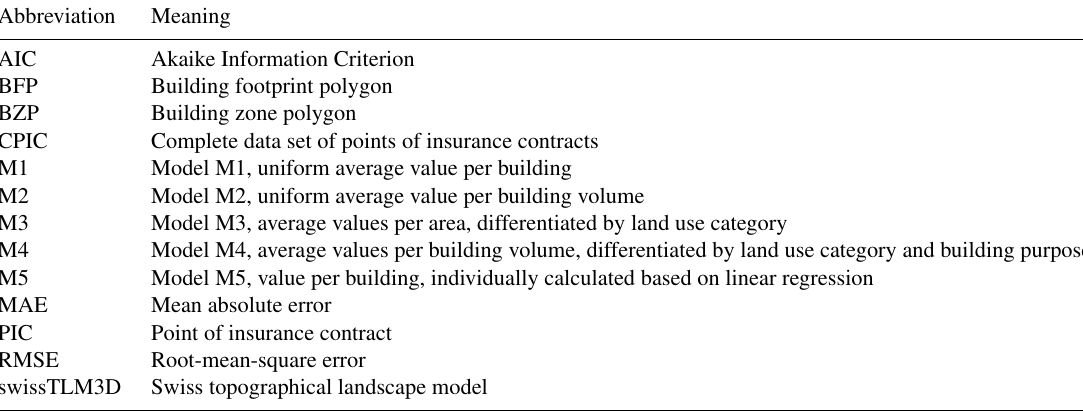
Table A2. Abbreviations used in the text in alphabetical